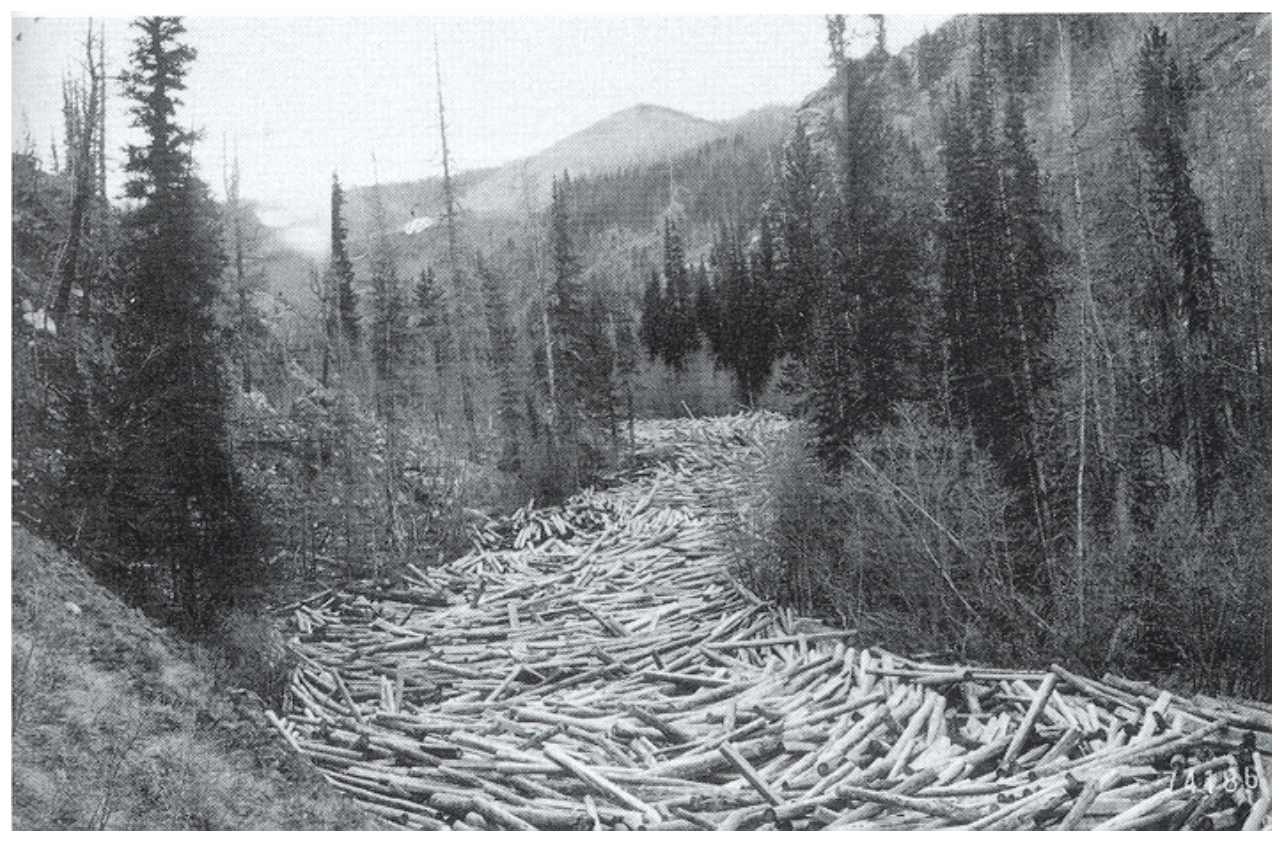
Fig. 5 . Ties and saw